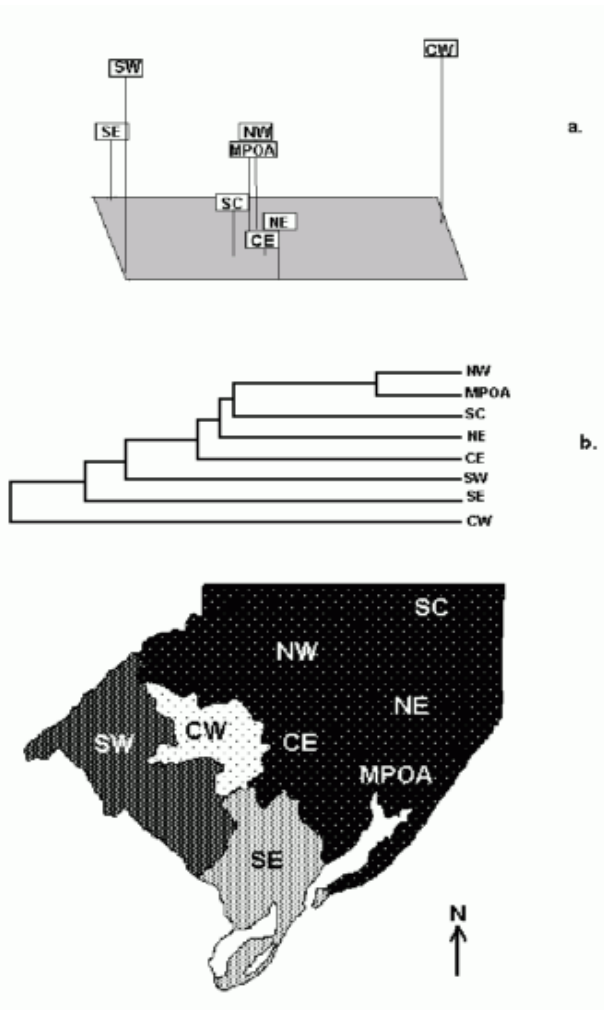
distances, (c) map of both A